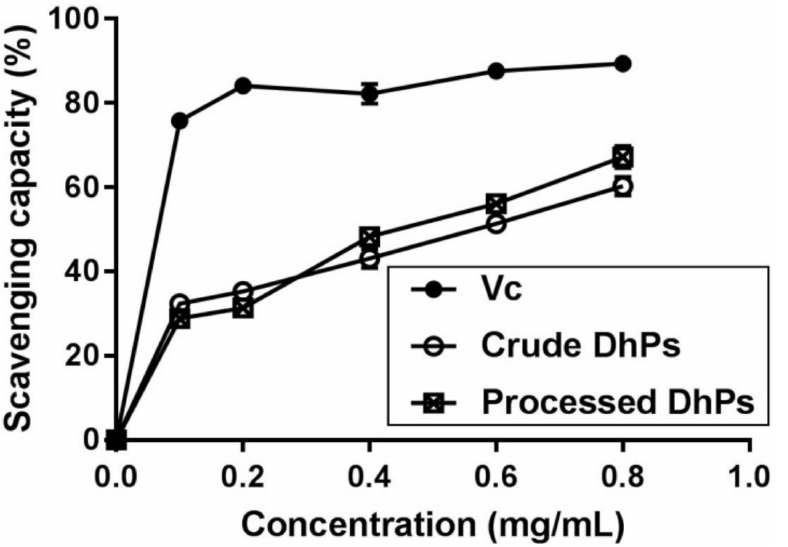
Figure 3. Determination of DPPH free radical scavenging capacity. All data in Figure 3 are presented as mean with SD and n = 3 per